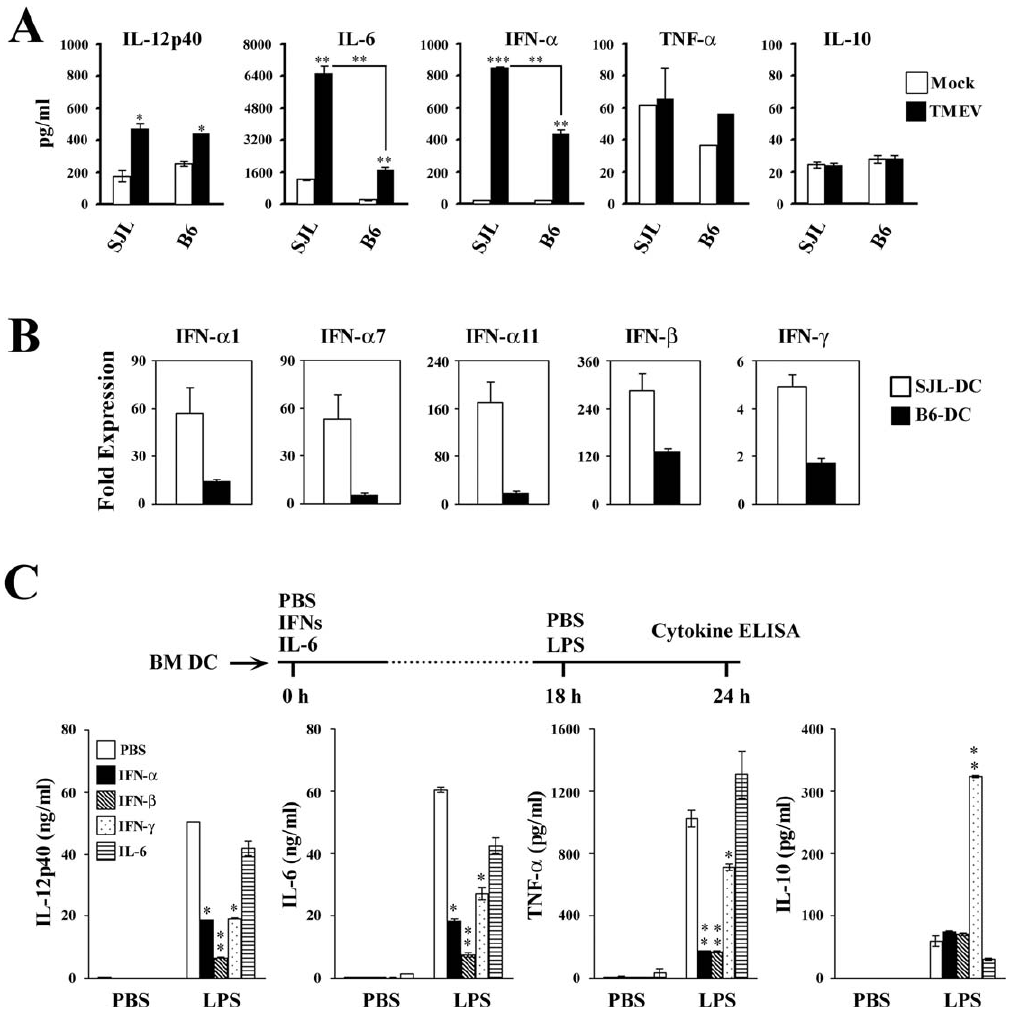
Figure 2. Cytokines Produced by Infected DCs and Their Effects on DC Activation (A) SJL and B6 DCs of a 5-d culture of BMCs were infected with TMEV for 24 h and concentrations of cytokines secreted were determined by ELISA. Statistically significant differences from the values in mock-infected DCs are indicated with asterisks (*, p , 0.05; **, p , 0.01; ***, p , 0.001). (B) SJL and B6 DCs were infected with TMEV for 8 h. Total RNAs from DCs were prepared for quantitative real-time PCR analysis. Data are expressed by fold increases as compared to mock-infected cells. Results are shown as mean plus SD. (C) SJL DCs were treated with IFN- a (1,000 U/ml), IFN- b (1,000 U/ml), IFN- c (10 ng/ml), IL-6 (100 ng/ml), or left untreated for 24 h. LPS was added for the final 6 h of culture. Cytokine levels in supernatants were determined with ELISA. Statistical differences between the values of untreated and treated DCs are indicated with asterisks (*, p , 0.05; **, p , 0.01).